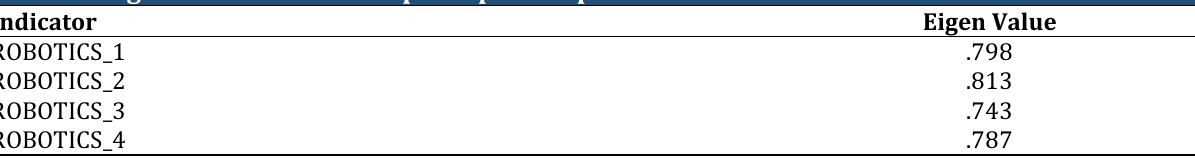
Table 8: Eigen scores of the first principal component